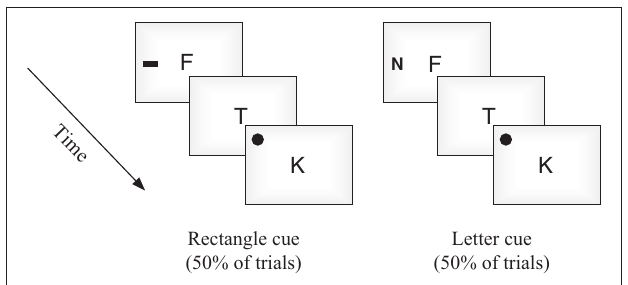
FIGURE 8 | The two different cue types used in Experiment 2.